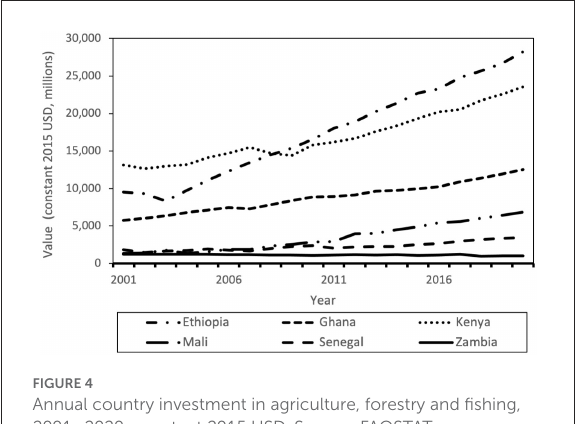
FIGURE4 Annual country investment in agriculture, forestry and fishing, 2001–2020, constant 2015 USD. Source: FAOSTAT.